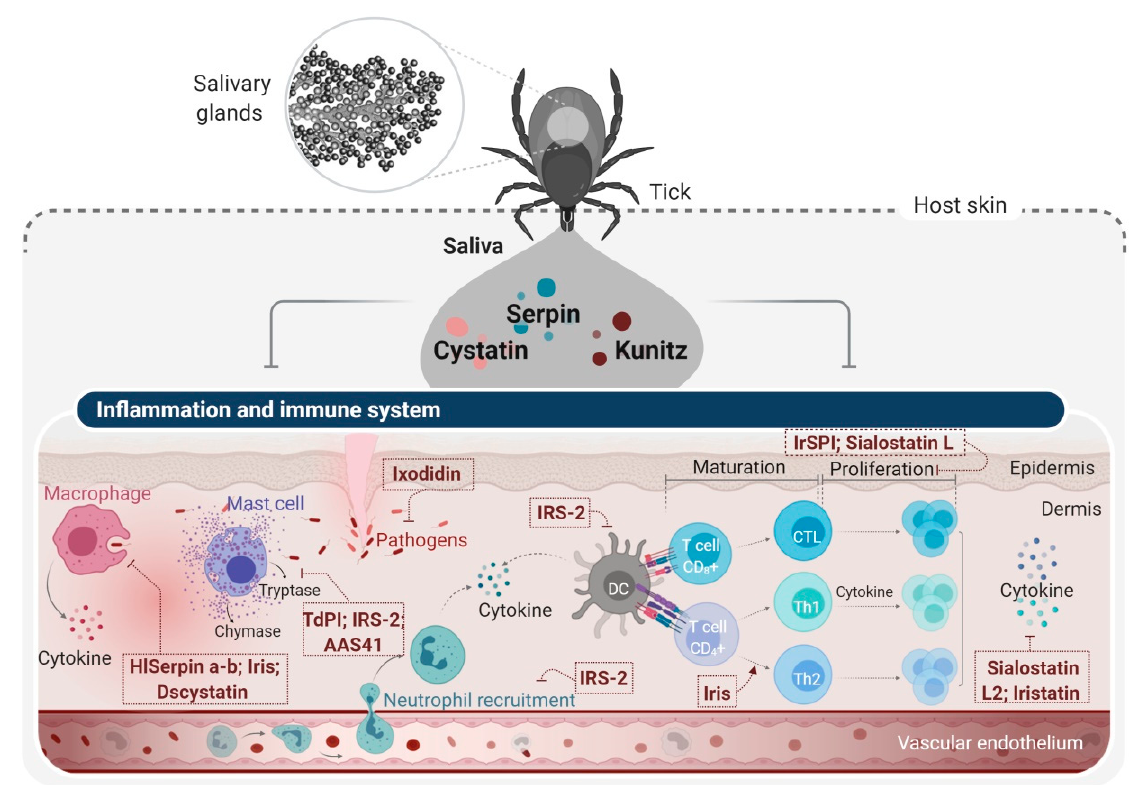
Figure 4. Examples of protease inhibitors from tick salivary glands with immunomodulatory effects. Several PIs from tick salivary glands have been described for their anti-inflammatory activity such as HlSerpin a-b, Dscystatin, Ixodidin, TdPI, and AAS41 or as immunomodulatory candidates including Iris, IRS-2, Sialostatin L2, Iristatin, and IrSPI.